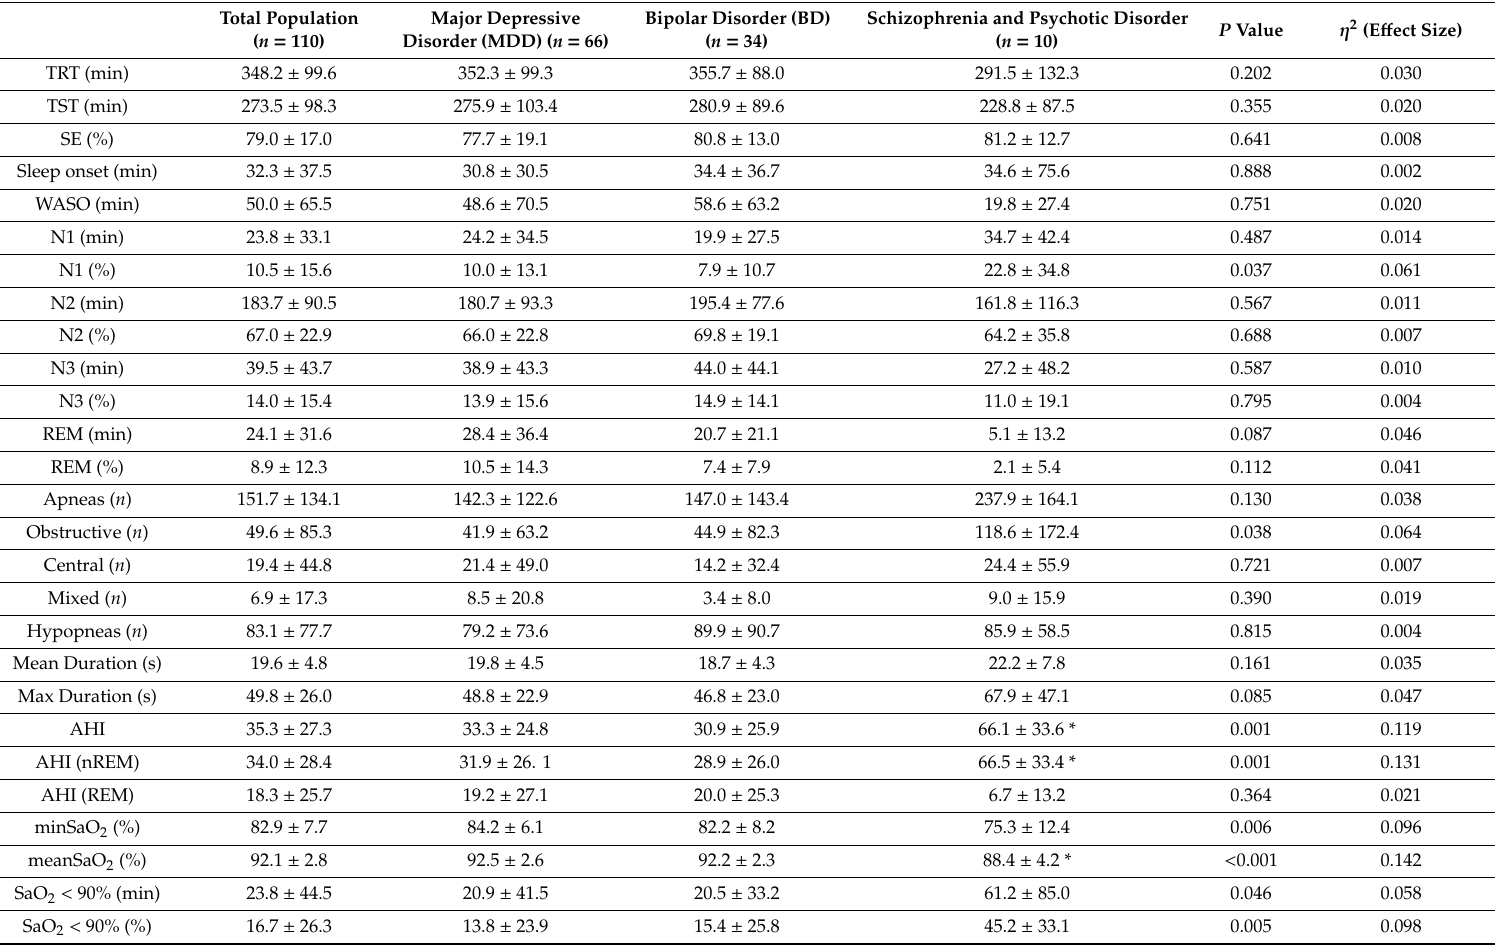
Table 3. Sleep characteristics of the study groups (mean ±